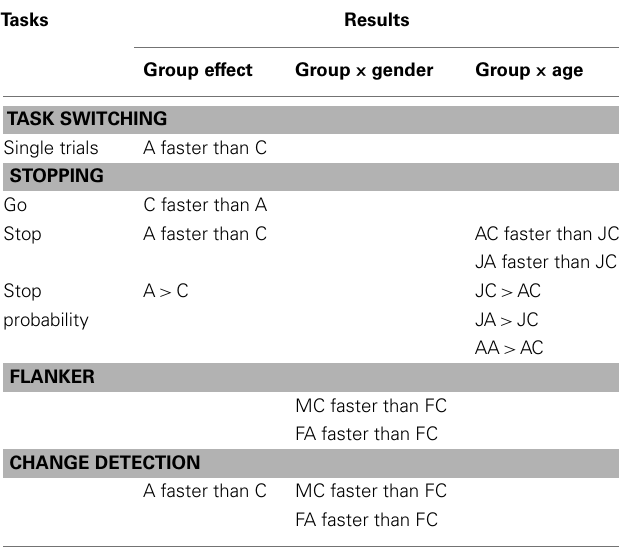
Table 3 | Summary of significant main effects and interactions.